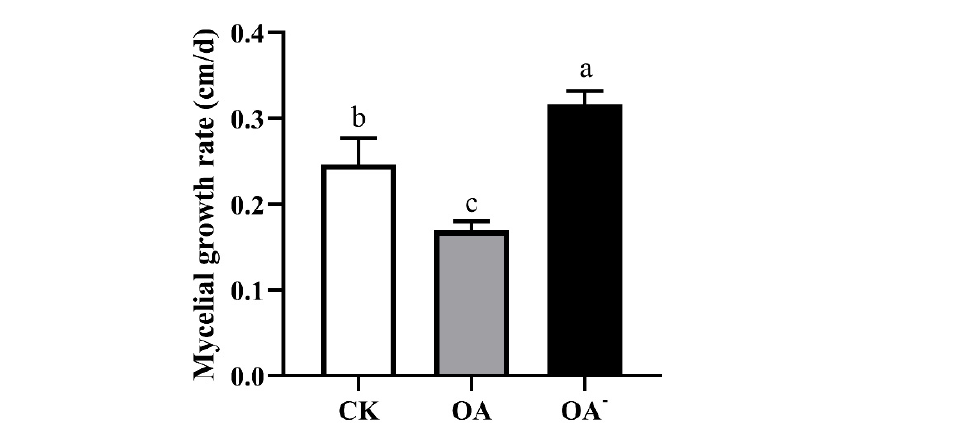
Figure 6. Growth rate of the S. latifolia mycelium in PSM supplemented with OA and OA - . CK: PSM, OA: PSM supplemented with 10 mM OA, OA - : PSM supplemented with 4 mM OA - . Data were analyzed with Duncan’s ANOVA test. Error bars represent the standard deviation of three replicates. Different letters indicate significant differences between the lines ( p ≤ 0.05).